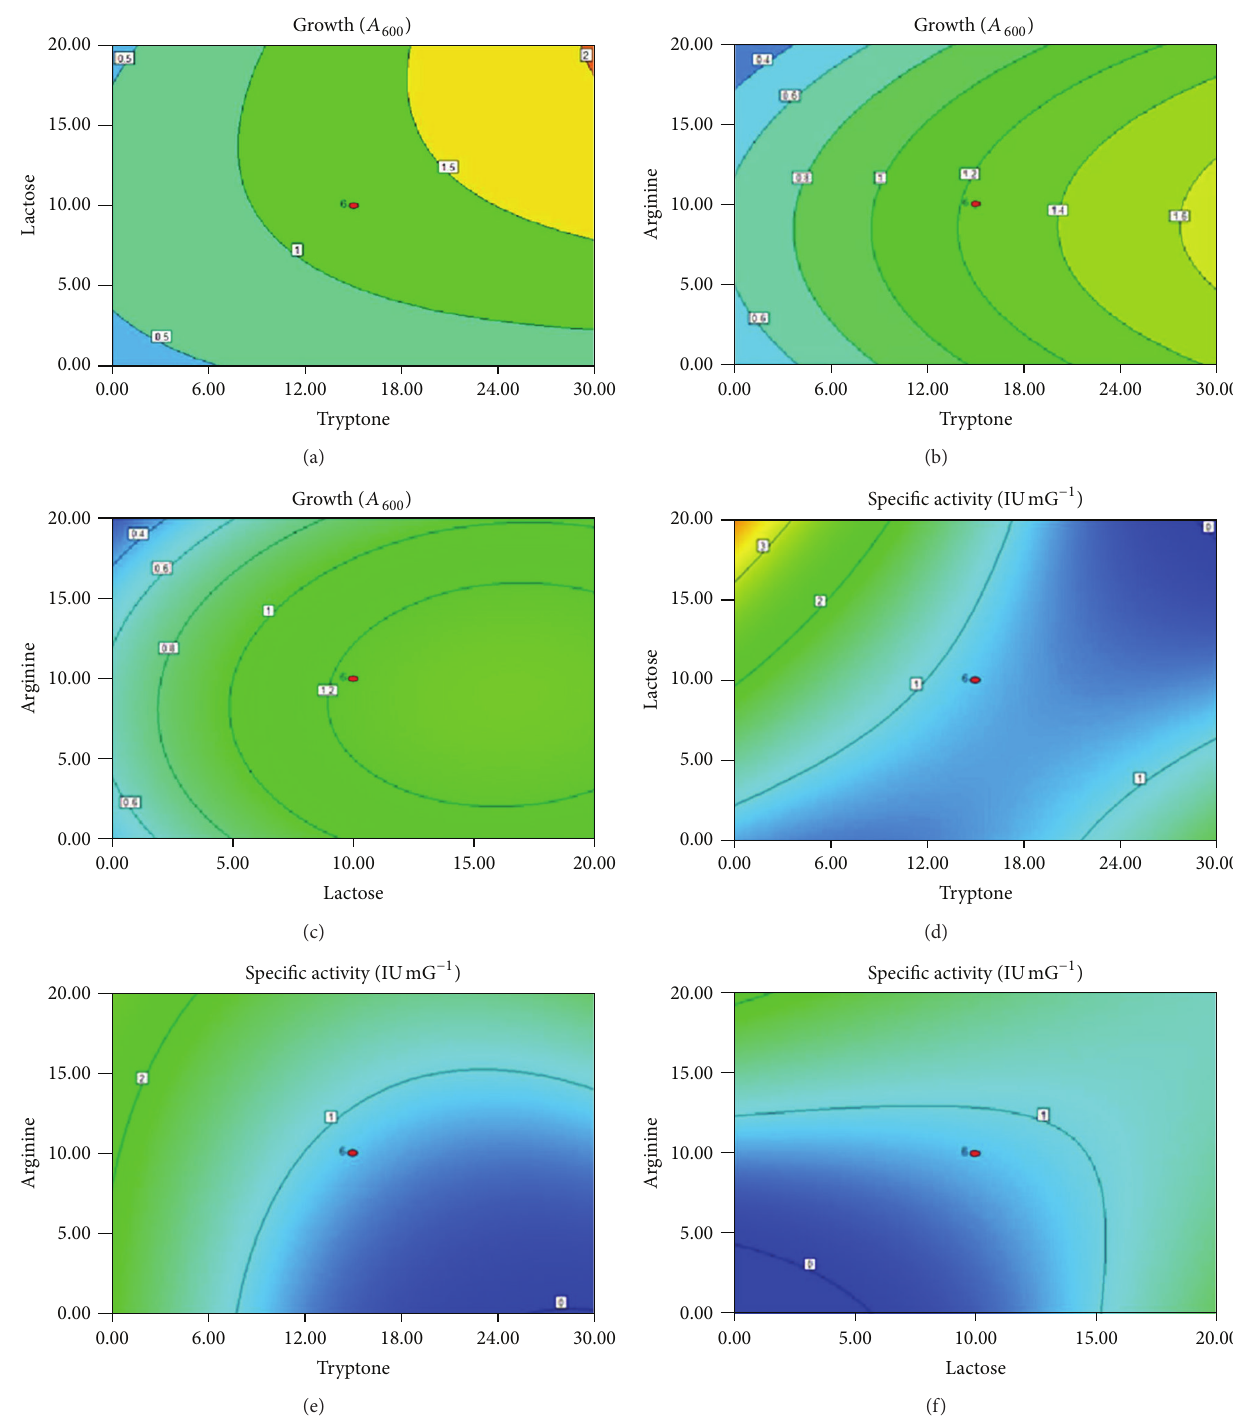
Figure 13: 2D contour plot showing effects and interaction of (a) lactose (g/L) and tryptone (g/L) (b) arginine (g/L) and tryptone (g/L) (c) arginine (g/L) and lactose (g/L) on growth at 𝐴 600 of E. faecium isolate GR7 and (d) lactose (g/L) and tryptone (g/L) (e) arginine (g/L) and tryptone (g/L) (f) arginine (g/L) and lactose (g/L) on specific ADI activity of E. faecium sp.